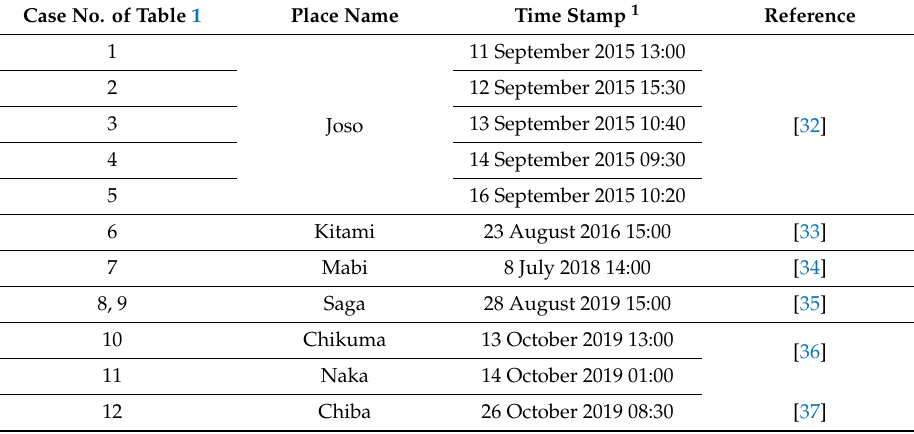
Table 2. Reference data provided by the Geospatial Information Authority of Japan (GSI) for validation. Case No. of Table 1